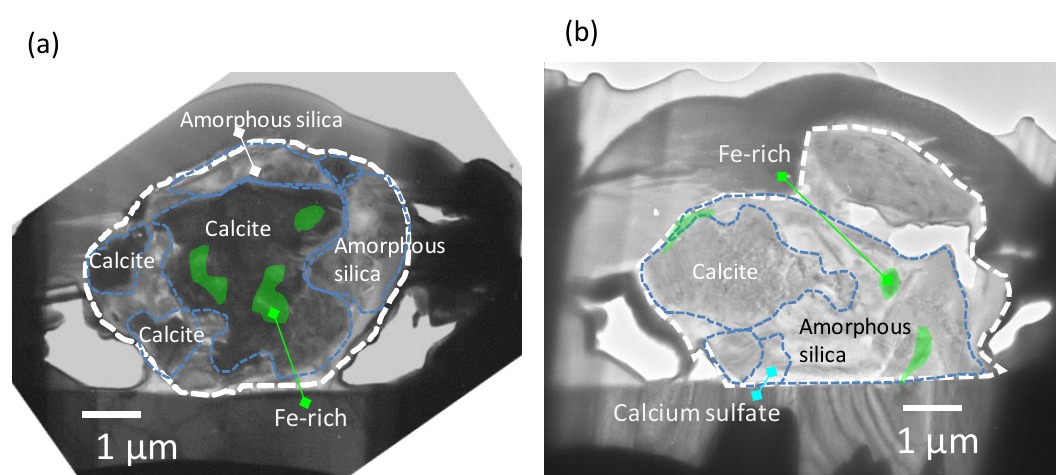
Figure 5. Deduced internal heterogeneous chemical and mineralogical structures within the cross-sections of Dust Particles 1 ( a ) and 2 ( b ) based on results of TEM, EDS, and SAED analyses. Sulfur was also detected in a domain in spot I (shown as a red arrow in the S-map of Figure 4b). Ca and Si peaks were found in EDS spectra of spot I. The area might have contained calcium sulfate. Though Fe was undetected from large area of the cross-section, Fe-rich small domains were found in